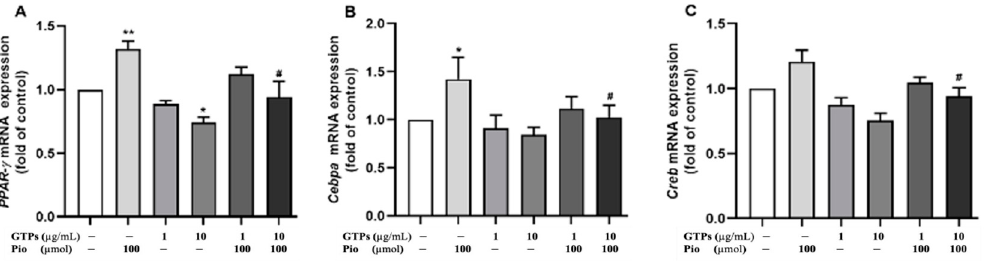
Figure 3. Effects of green tea polyphenols (GTPs) on mRNA expression of Ppar γ Cebpa and Creb . Gene expression of Ppar γ ( A ), Cebpa ( B ) and Creb ( C ) was detected by qRT-PCR in cell cultures with DMEM (control), pioglitazone (Pio, 100 µ mol), GTPs (1 and 10 µ g/mL) and GTPs plus Pio for 21 days. Data from 4 separate experiments are expressed as means ± SE. * p <0.05 and ** p < 0.01 GTPs and pioglitazone treatments vs. control. # p < 0.05 GTPs plus pioglitazone vs. pioglitazone alone.